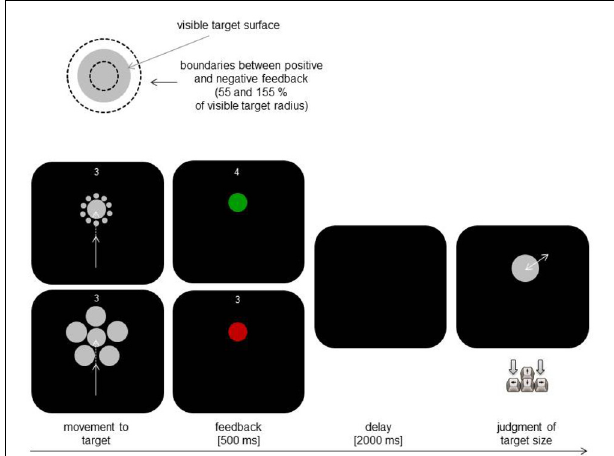
An ANOVA including hit rates relating to the “real” perfor-